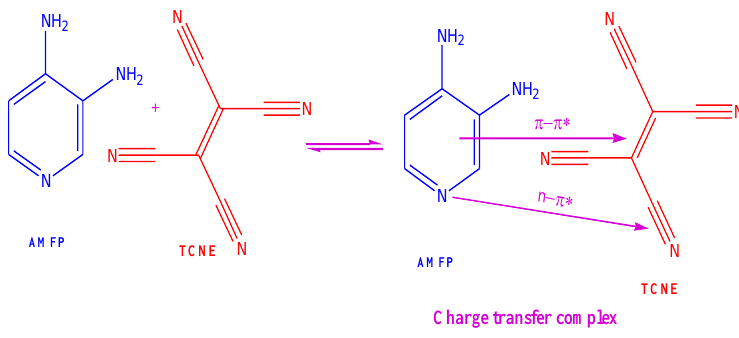
Figure 2. Electronic spectra of 1.0 × 10 − 4 mol L − 1 AMFP, 1.0 × 10 − 4 mol L − 1 TCNE, and (1:1) AMFP – TCNE CT complex in DCE. Scheme 2. The suggested reaction of AMFP with TCNE in DCE solvent. Scheme 2. The suggested reaction of AMFP with TCNE in DCE